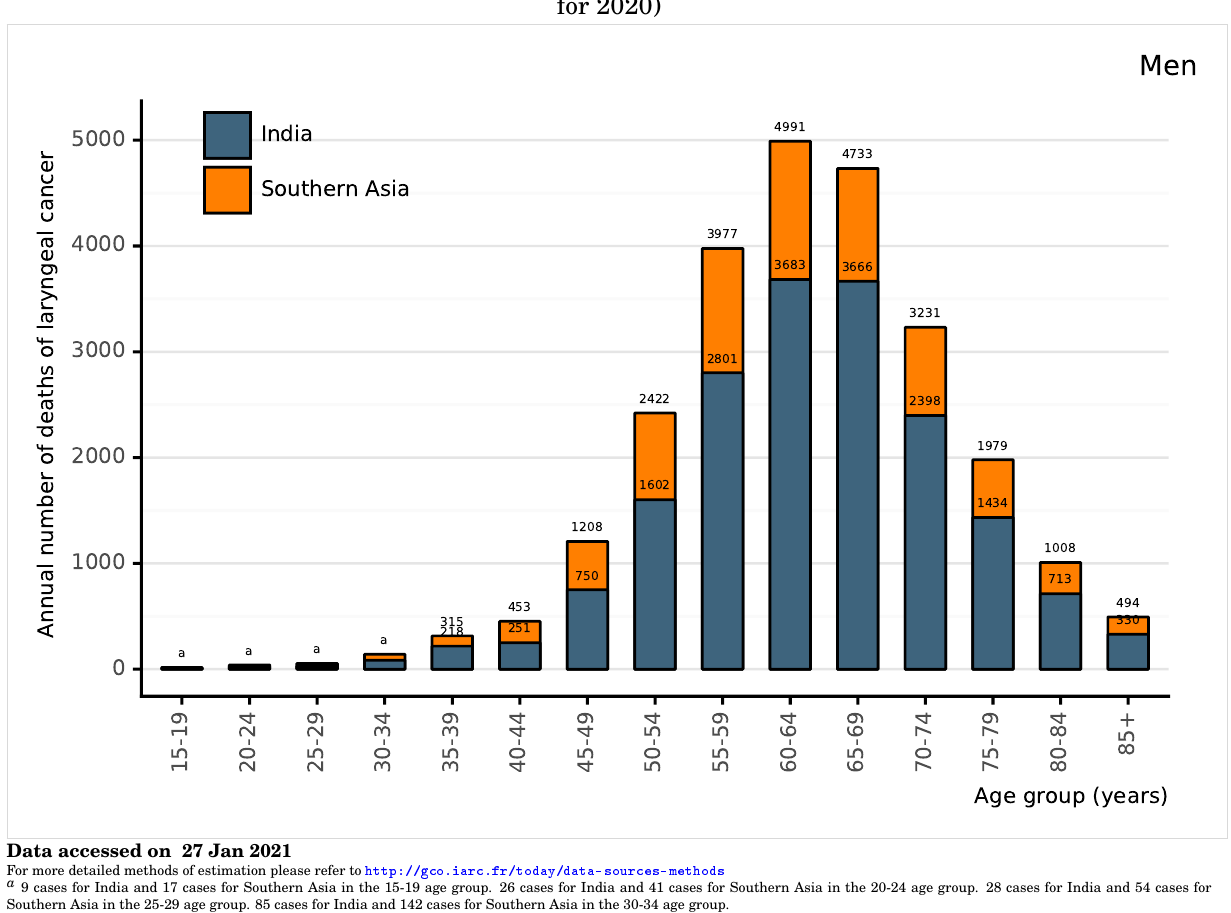
Figure 133: Annual number of deaths of laryngeal cancer among men by age group in India